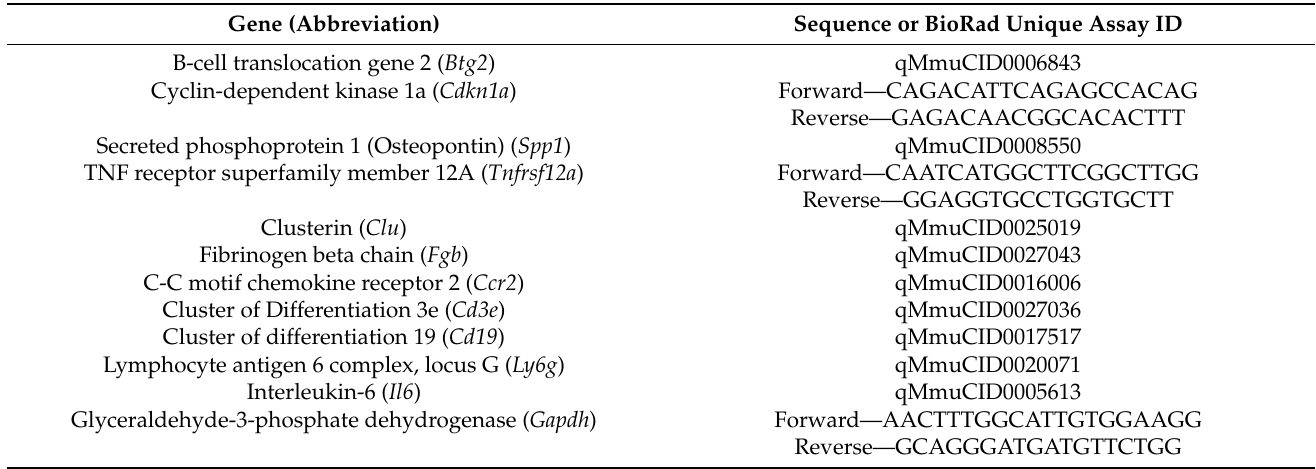
Table A2. Primers Used for